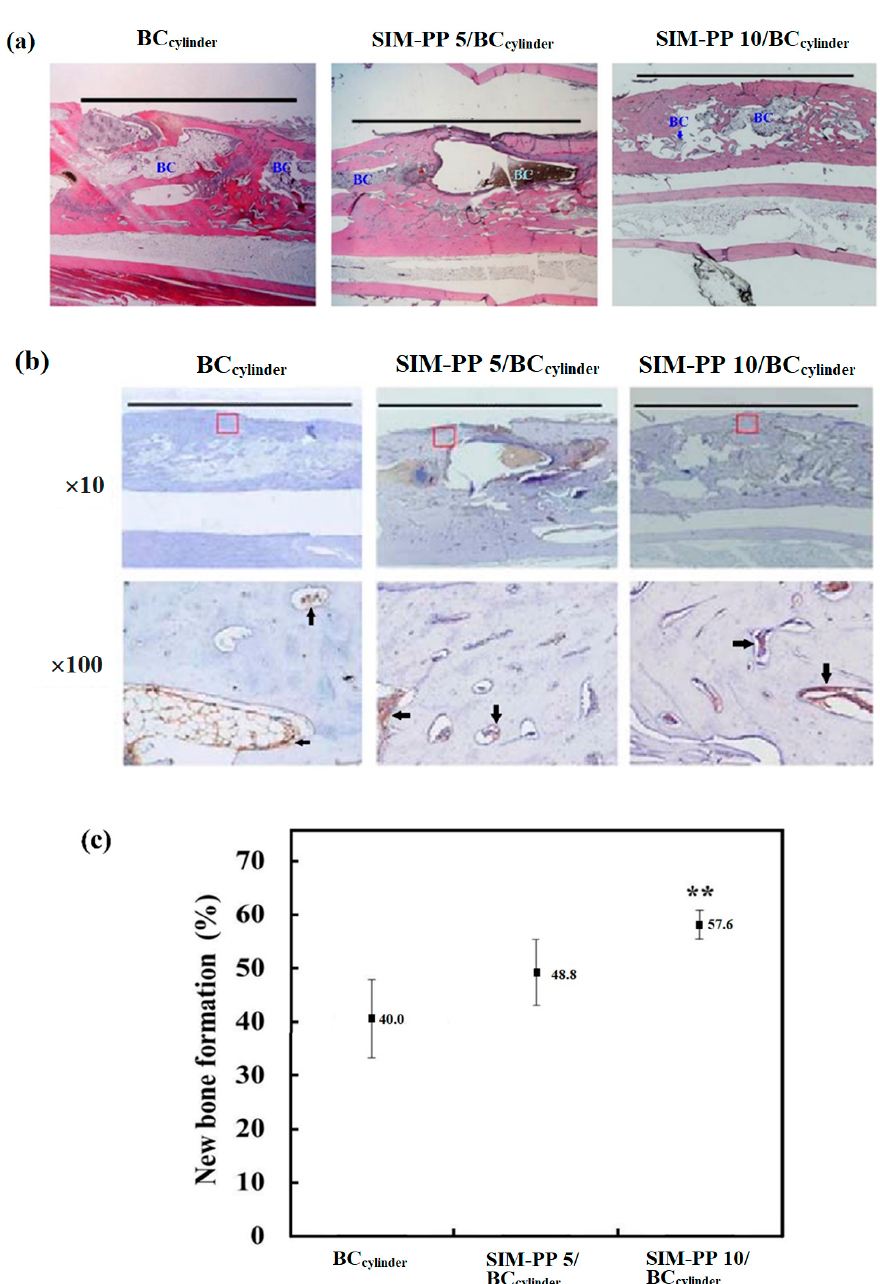
Figure 6. The SIM-PP 10/BC cylinder group had the highest new bone formation. H&E staining ( a ) and IHC staining of von Willebrand factor (VWF) ( b ) of the 10-mm nonunion radial bone defect rabbit model at 10 weeks after implantation of BC cylinder samples ( φ 1 3.5 mm; φ 2 1.5 mm; h 10 mm), 5.0 µ mol of SIM in SIM-PP/BC cylinder and 10.0 µ mol of SIM in SIM-PP/BC cylinder . BC: bioceramic. Arrows indicate the VWF staining. Quantification of new bone formation of these 10-mm nonunion radial bone defect rabbit groups ( c ). ( N = 3; ** p < 0.01 compare BC cylinder ). Scale bars = 10 mm.